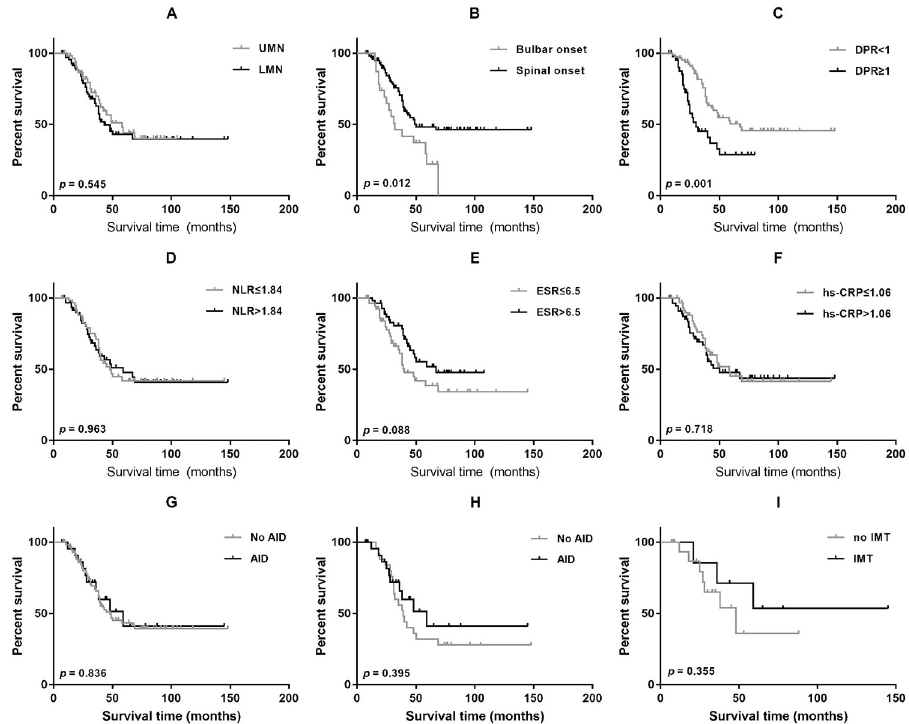
Fig 1. The effect of clinical parameters and immunotherapy on survival. Survival curves of ALS patients categorized by predominant involvement of UMN or LMN (A), site of onset (B), DPR (C), NLR (D), ESR (E), hs-CRP (F), coexisting AID (G), and immunotherapy (H-I). Patients with bulbar onset and rapid disease progression had worse survival when the relationship between clinical features and survival was analyzed (A-C). No significant difference in survival was found in patients grouped by serum inflammatory biomarkers. Coexisting autoimmune diseases do not influence the survival in ALS patients before and after propensity score matching (G-H). The patients with coexisting ALS and AIDs who had a history of immunotherapy presented a trend of longer survival. UMN, upper motor neuron; LMN, lower motor neuron; DPR, disease progression rate; NLR, neutrophil-lymphocyte ratio; ESR, erythrocyte sedimentation rate; hs-CRP, hypersensitive C-reactive protein; AID, autoimmune disease; IMT, immunotherapy.